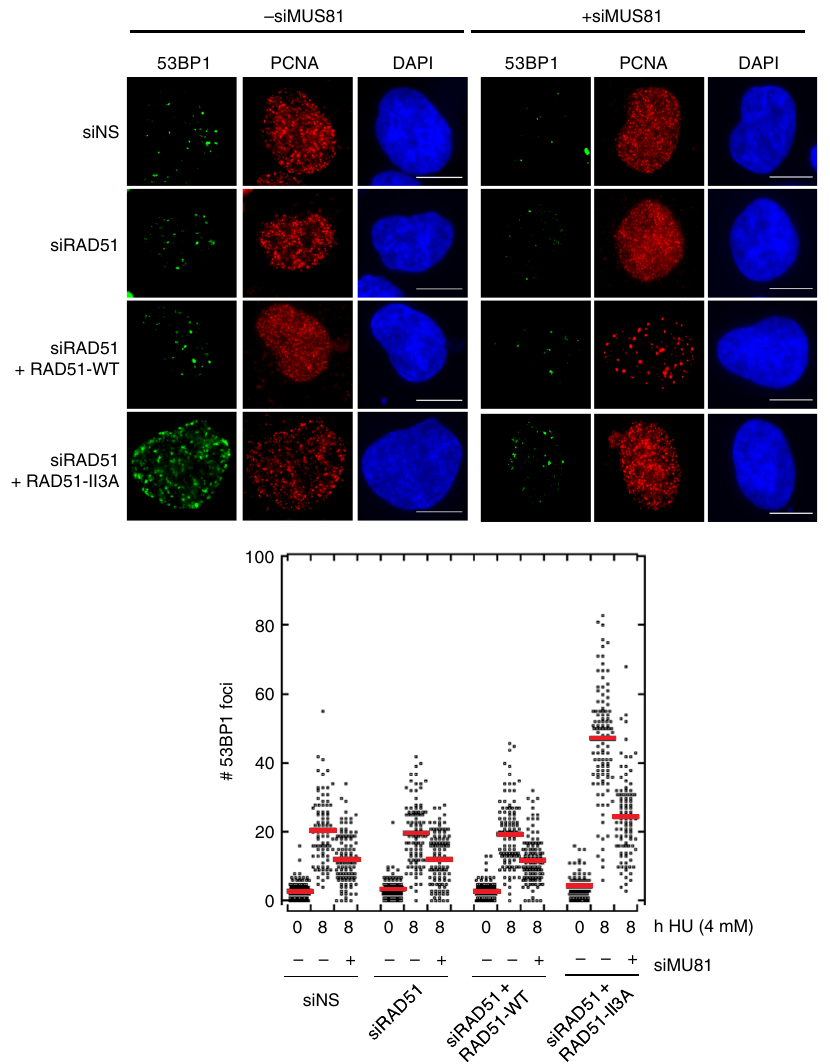
Fig. 5 hsRAD51-II3A expressing cells accumulate 53BP1 foci after treatment with HU. Representative images depicting 53BP1 foci (green) in PCNA (red) positive cells after the indicated treatments. DNA is stained in blue. Scale bar = 10 μ m. Dot plot depicts quantitation of 53BP1 foci after indicated treatments. Data is combined data consisting of at least 100 nuclei from two independent experiments. Red line represents the mean. Values are presented as mean ± SD. Statistical signi fi cance was determined using the Mann – Whitney U test. Source data are provided as a source data fi